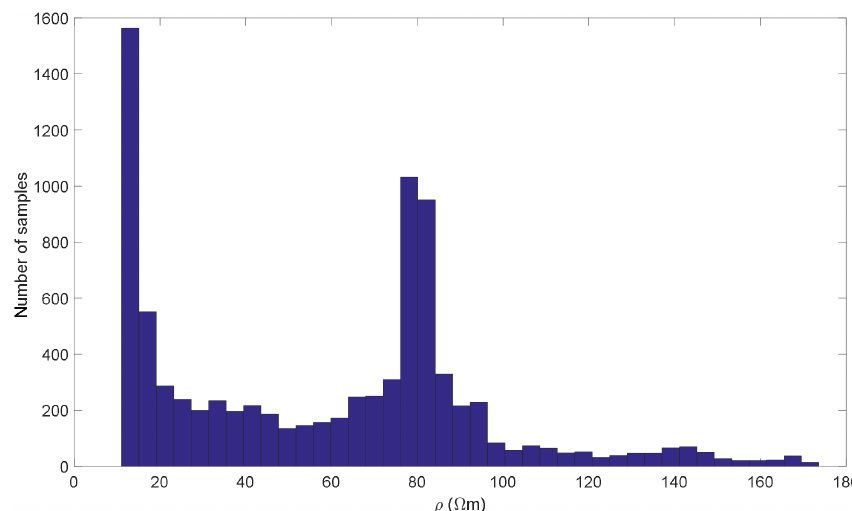
Figure 7. Histogram of the electrical resistivity values determined for the ERI section shown in Fig. 5.